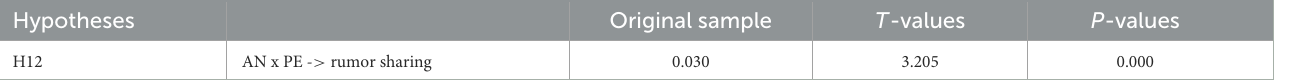
TABLE 9 Moderation